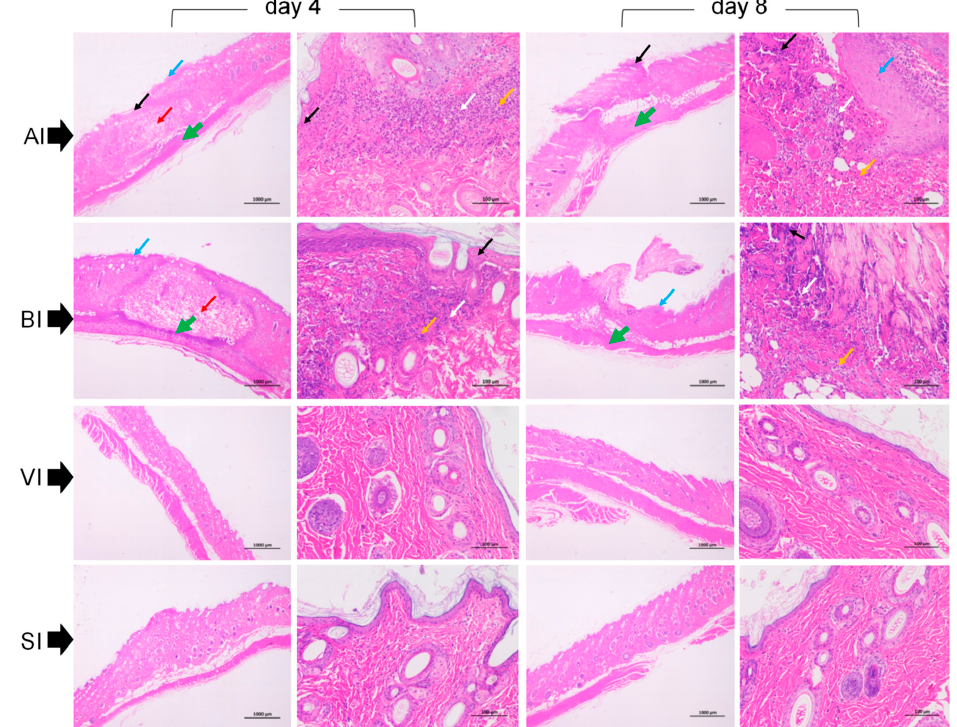
Figure 5. Histological changes in the skin of guinea pigs associated with S. invicta stings ( BI ), intradermal injection of alkaloids ( AI ), vehicle control injection ( VI ), and injection of normal saline ( SI ). The left and right vertical images were collected 4 and 8 days after treatment, respectively. The black arrows indicate dissolved epidermal cells or nuclear pyroptosis, the blue arrows indicate thickening of the spinous layer on either side of the epidermal cells, the white arrows indicate dissolved collagen fibers, the orange arrows indicate neutrophilic infiltration of the dermis and subcutaneous tissue, the green arrows (bold line) indicate neutrophilic infiltration of the hypodermis, and the red arrows indicate irregularly arranged collagen fibers in the hypodermis.